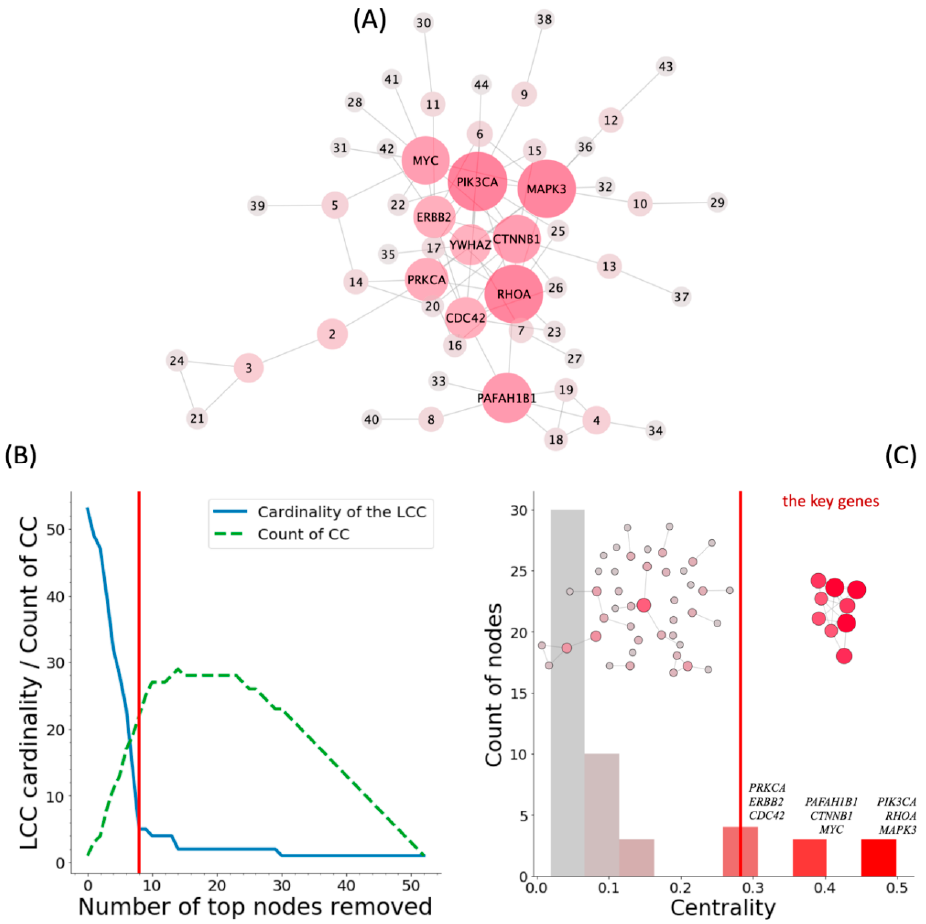
Figure 1. Selection of key protein-coding miR-375 target genes expressed in the heart muscle. ( A ). The largest connected component (LCC) of the network of miR-375 protein-coding target genes, which are fully presented in the Supplementary Material (Table S1); the figure provides names only for several genes of the highest centrality. ( B ). After the successive removal of the genes of the highest centrality, the LCC disintegrates and loses its connectivity. The plot shows the reduction in the LCC cardinality (blue line) and simultaneous enlargement of the connected components (CC) number (green dashed line) during nodes’ removal. ( C ) The histogram of centrality distribution of genes in the LCC; right network includes key nodes (marked on the histogram), left network—all but key nodes. The vertical red lines on figures (B) and (C) mark the cut-off level for selection of the key genes when the LCC cardinality hits a plateau. Di ff erences in the color of nodes (A, C) and columns (C) from gray to red mark the increase in the centrality of